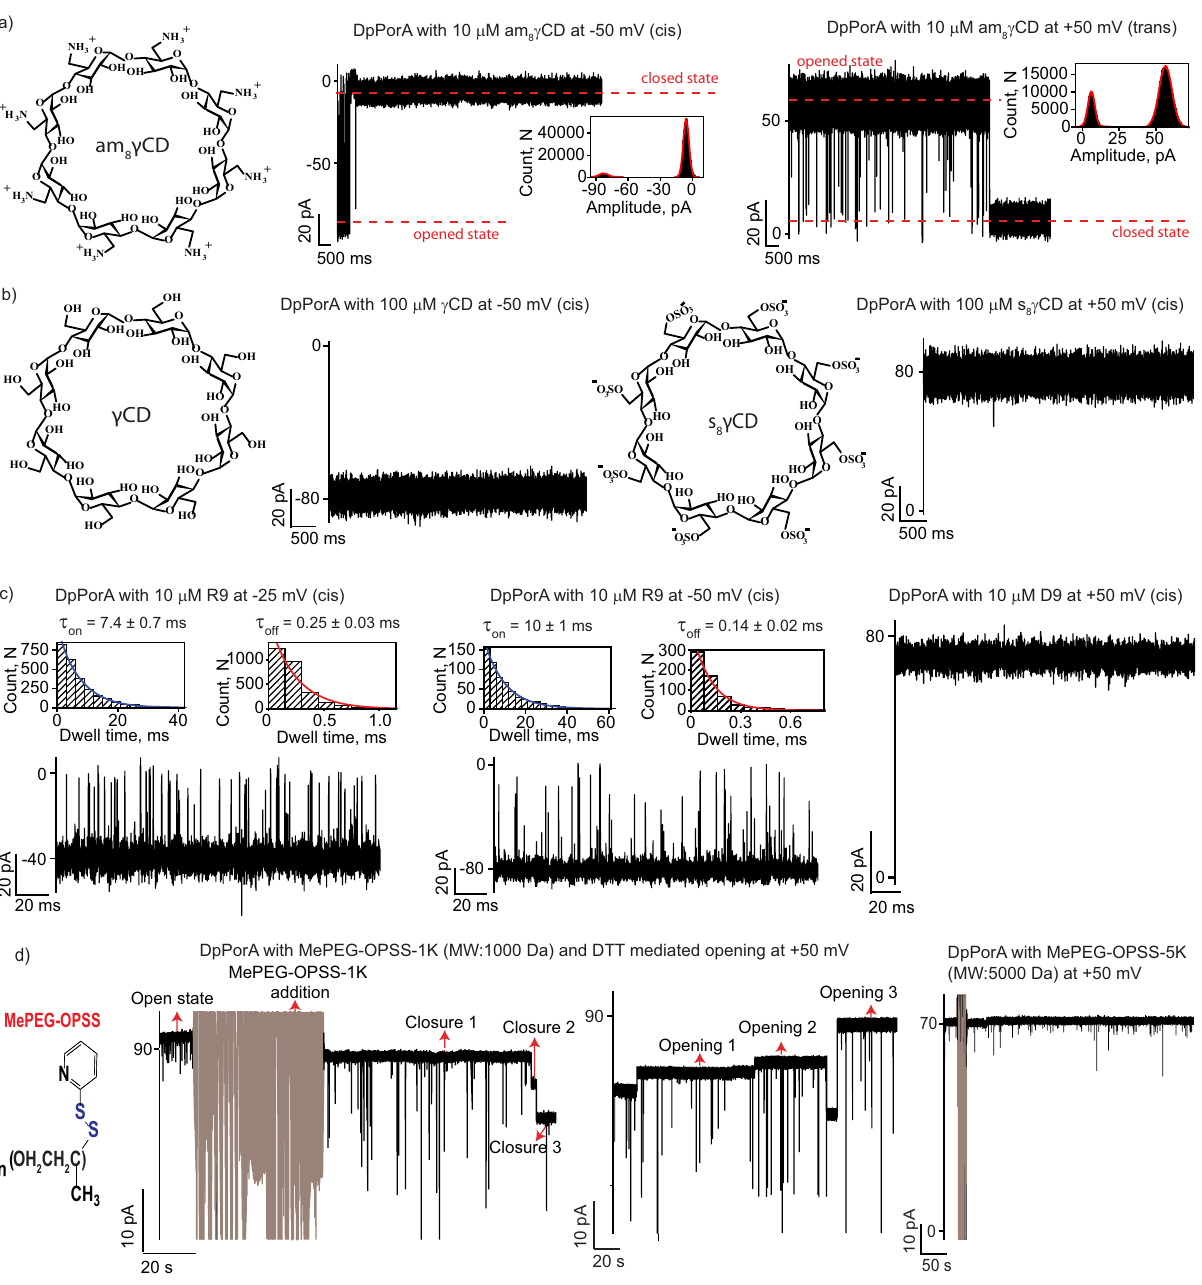
Fig. 2 | DpPorA for single-molecule sensing. a Chemical structure of cationic am 8 γ CD. Interaction of am 8 γ CD with single DpPorA (10 μ M, cis) at − 50mV and (10 μ M, trans) at +50mV. Inset shows the corresponding current amplitude histo- gram. b Chemical structure of neutral γ CD and interaction with single DpPorA (100 μ M, cis) at − 50mV. Chemical structure of anionic s 8 γ CD and interaction with single DpPorA (100 μ M, cis) at +50mV. c Interaction of nonaarginine (R9) with single DpPorA (10 μ M, cis) at − 25mV and − 50 mV. Insets show corresponding dissociationdwelltime( τ off )andassociationdwelltime( τ on )dwelltimehistograms